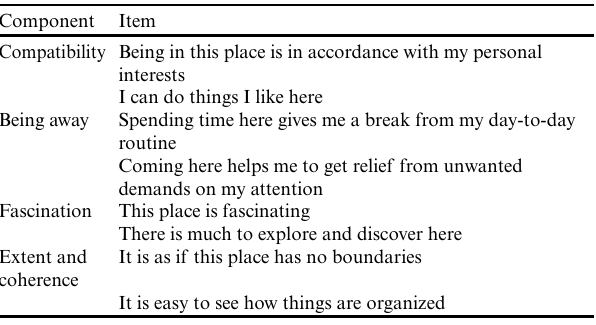
Table 2. List of items used to assess perceived